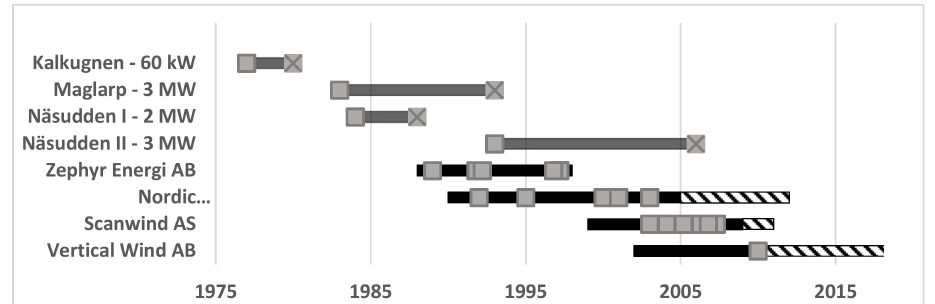
Figure 5. Timeline of the Swedish wind turbines. The markers represent erected turbines and for single turbines, decommissioning is also marked. Nordic Windpower’s continuation in China and the USA, GE’s continuation of ScanWind and Vertical Wind’s inactive period have dashed